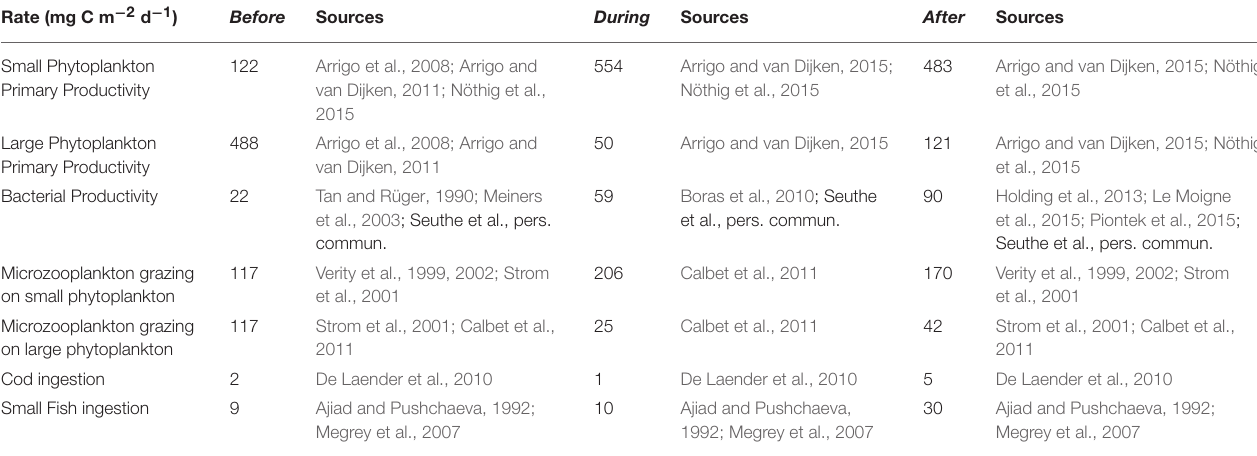
TABLE 2 | Rates used as “known” flows for the inverse analysis, in units of mg C m − 2 d − 1 .